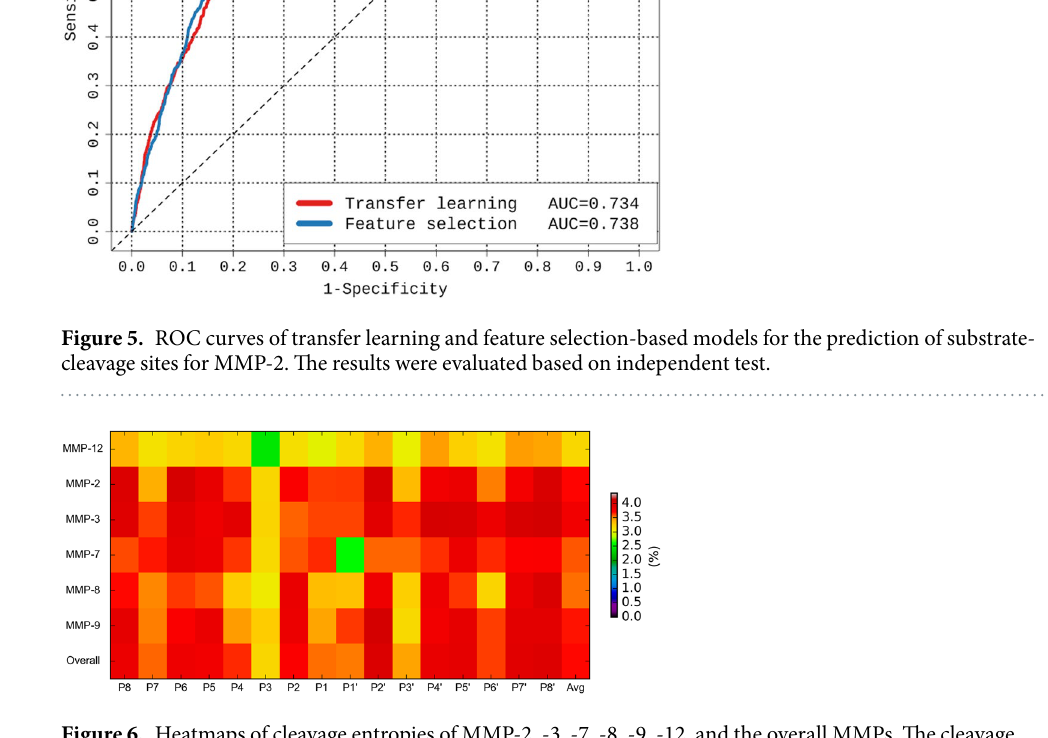
Figure 6. Heatmaps of cleavage entropies of MMP-2, -3, -7, -8, -9, -12, and the overall MMPs. The cleavage entropies of P8-P8 ′ positions surrounding the cleavage sites were calculated. The average values over all the P8-P8 ′ positions for each MMP were also calculated (indicated as “Avg”). Red colors indicate residue positions with larger cleavage entropy values (i.e. the corresponding protease has a higher cleavage specificity), while light yellow or green colors indicate residue positions with smaller cleavage entropy values (i.e. the corresponding protease has a lower cleavage